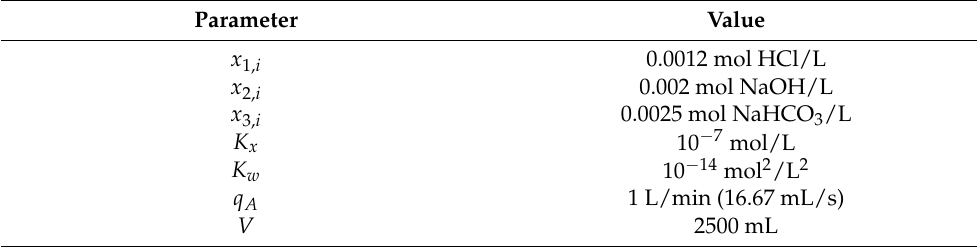
Table 1. Model parameters for pH